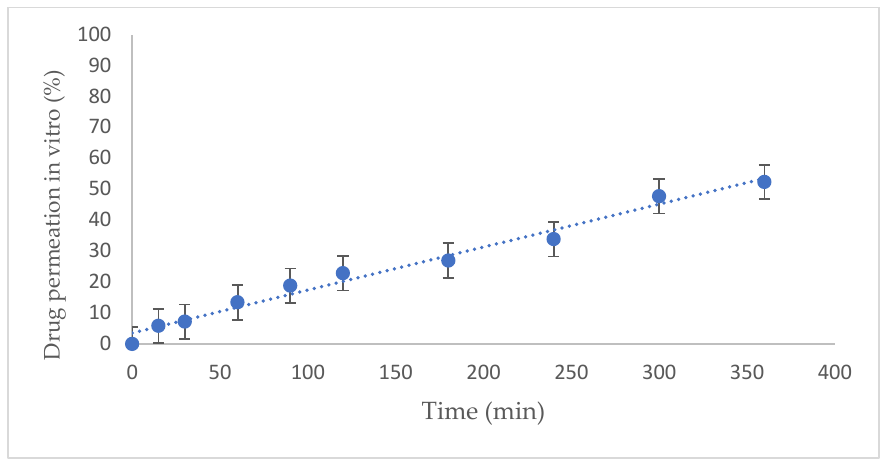
Figure 3. In vitro permeation of dexamethasone treatment (%) through porcine vaginal mucosa using Franz diffusion cells over time (minutes). Simulated vaginal fluid was used for the donor and acceptor solutions, and cells were incubated at 37 °C ± 1·°C. The diffusion tests were run six times and are presented as the mean ± standard deviation (SD) of the mean.